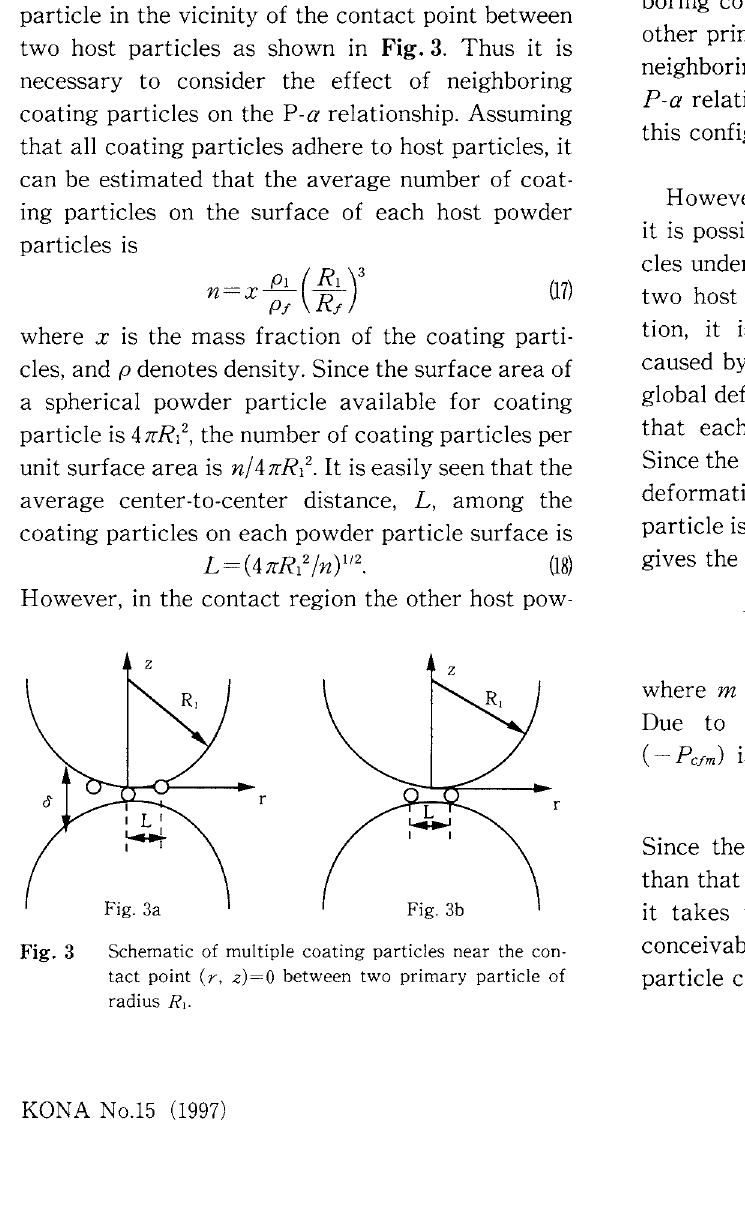
Schematic of multiple coating particles near the con tact point (r, z)=O between two primary particle of radius